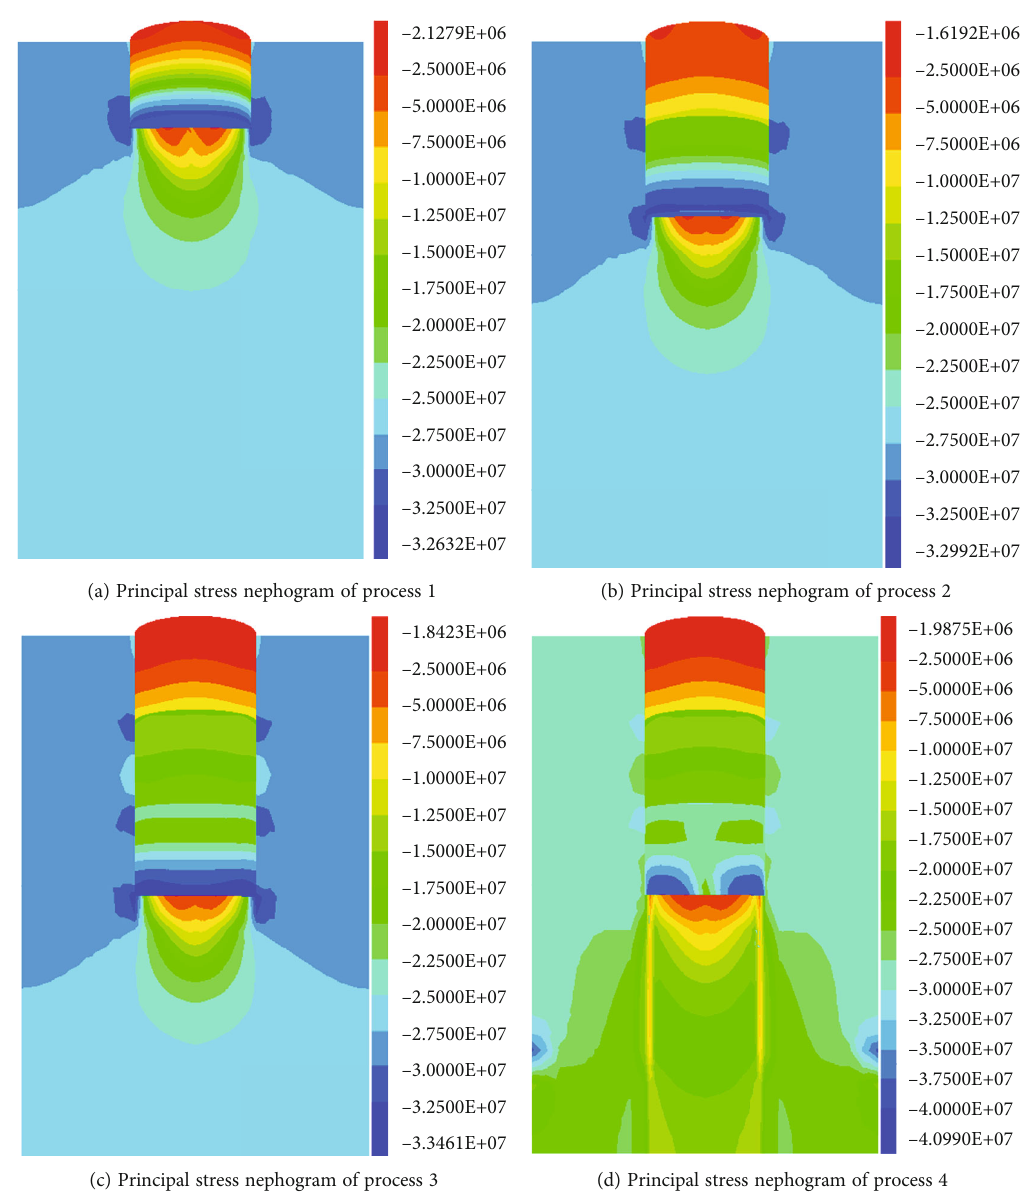
Figure 8: Maximum principal stress